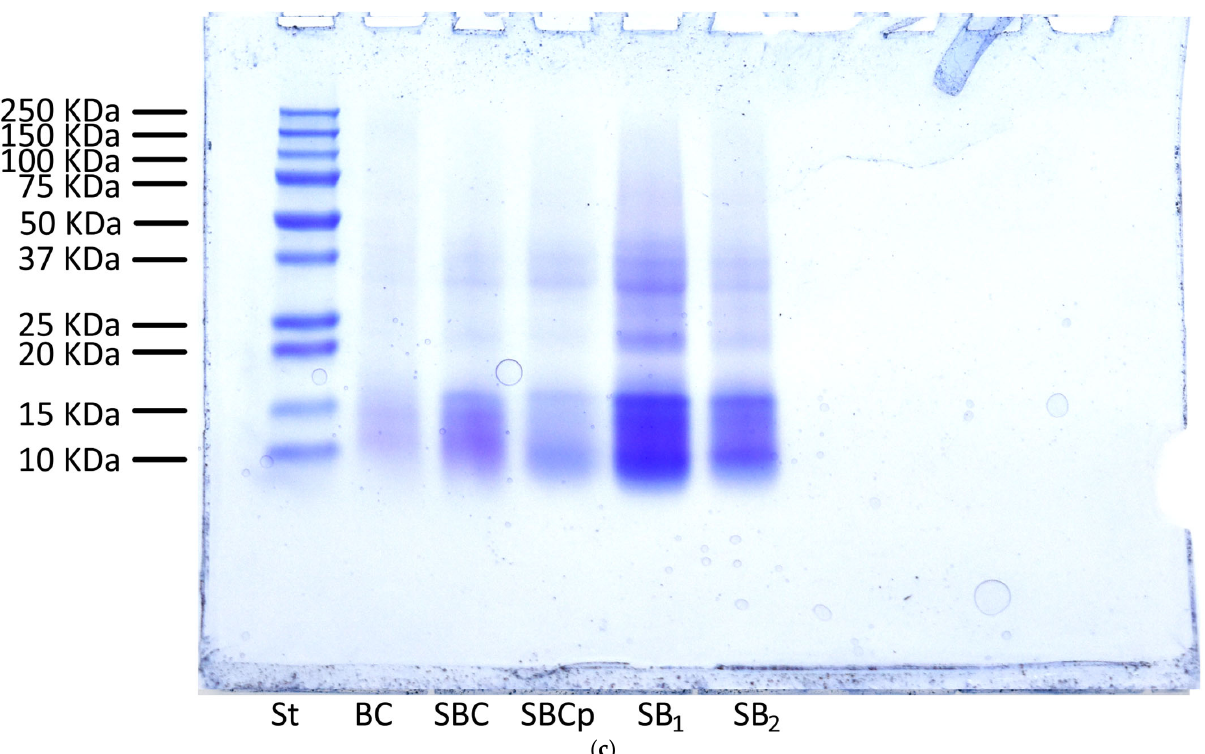
Figure 4. Result of the band pattern of the protein compounds in gel (SDS ‐ PAGE) by electrophoresis. ( a ): doughs at T0; ( b ): fermented doughs; ( c ): baked breads. St: standard; BC: bread control; SBC: sourdough bread control; SBC p : sourdough bread control with propionate; SB 1 : sourdough bread with L. plantarum 5L1 inoculum (0.5%); SB 2 : sourdough bread with L. plantarum 5L1 inoculum (5%).